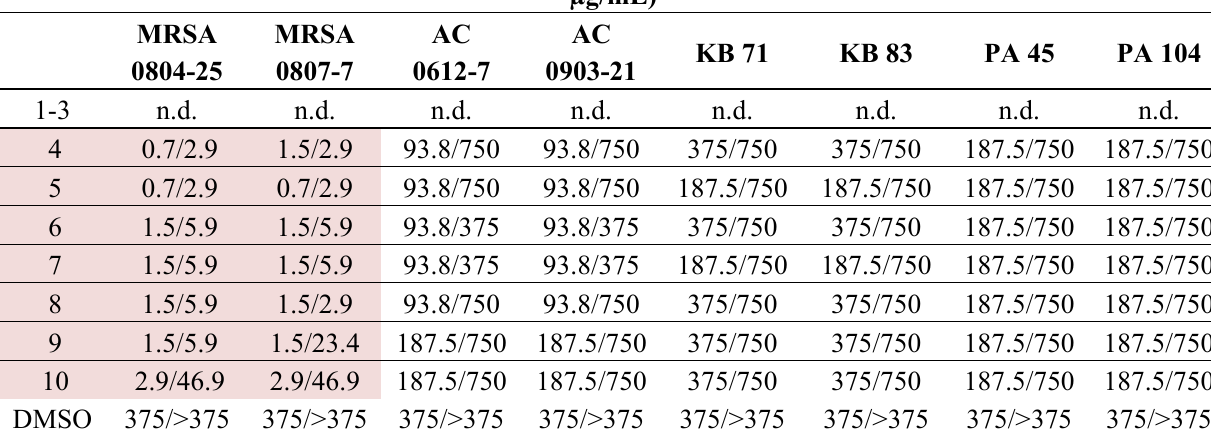
Table 4. Second level antibacterial screening.